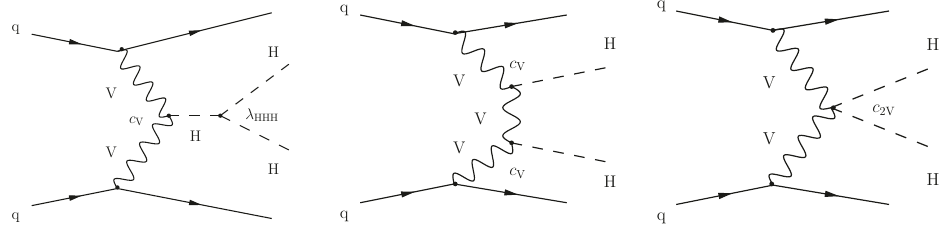
Figure 2 . Feynman diagrams that contribute to the production of Higgs boson pairs via VBF at LO. On the left the diagram involving the HHH vertex ( λ two HVV vertices ( c ), and on the right the diagram with the HHVV vertex ( c V √ at s = 8 and 13 TeV [19–23, 23–29]. Searches in the γγ bb channel performed by